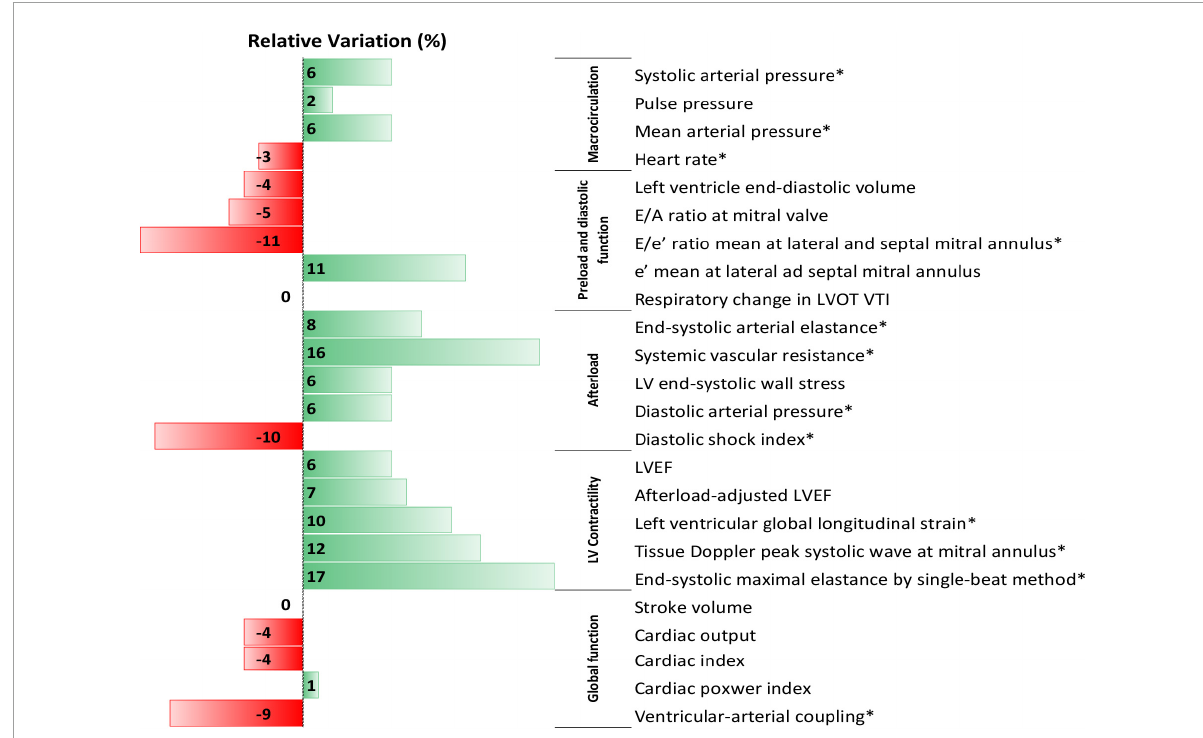
FIGURE2 Data bars of median values of percent relative variation in hemodynamic and echocardiographic parameters after initiation of low-dose steroid therapy in septic shock patients. ∗ Denote an adjusted p -value < 0.05 with Benjamini-Hochberg correction as compared to before with after low-dose steroids